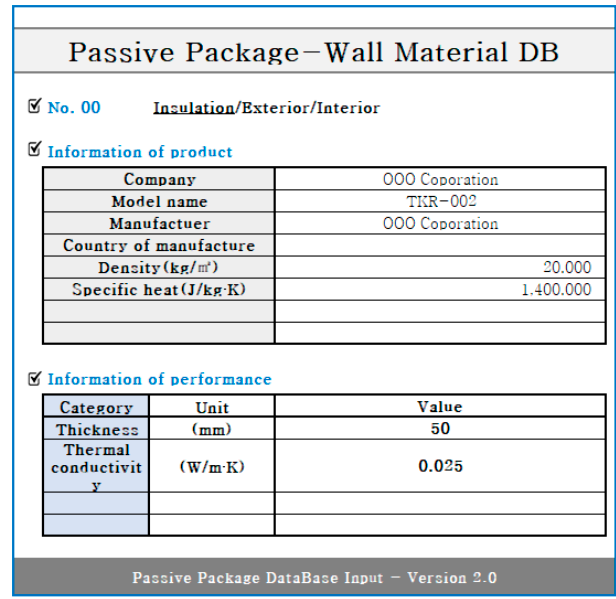
Figure 5. Example of passive technology package DB.